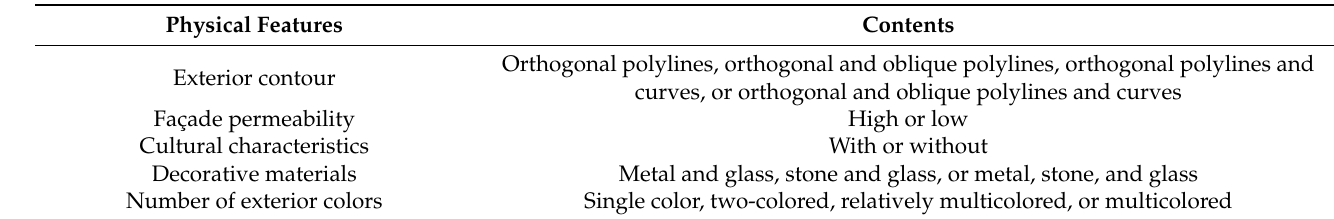
Table 2. Physical features of entrance